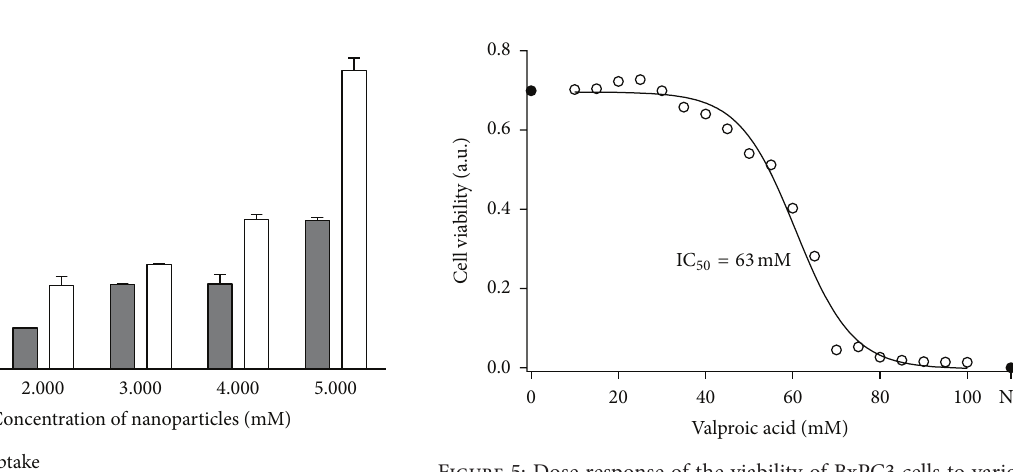
Figure 3: TEM bright field micrograph of Zn 2 Al(OH) 6 (FITC) with a slow scan at 2- 𝜃 between 2.5 and 7.5.